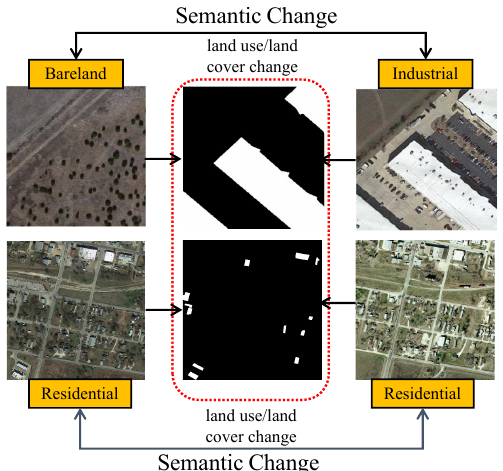
Figure 1. Scene semantic change and land use/land cover